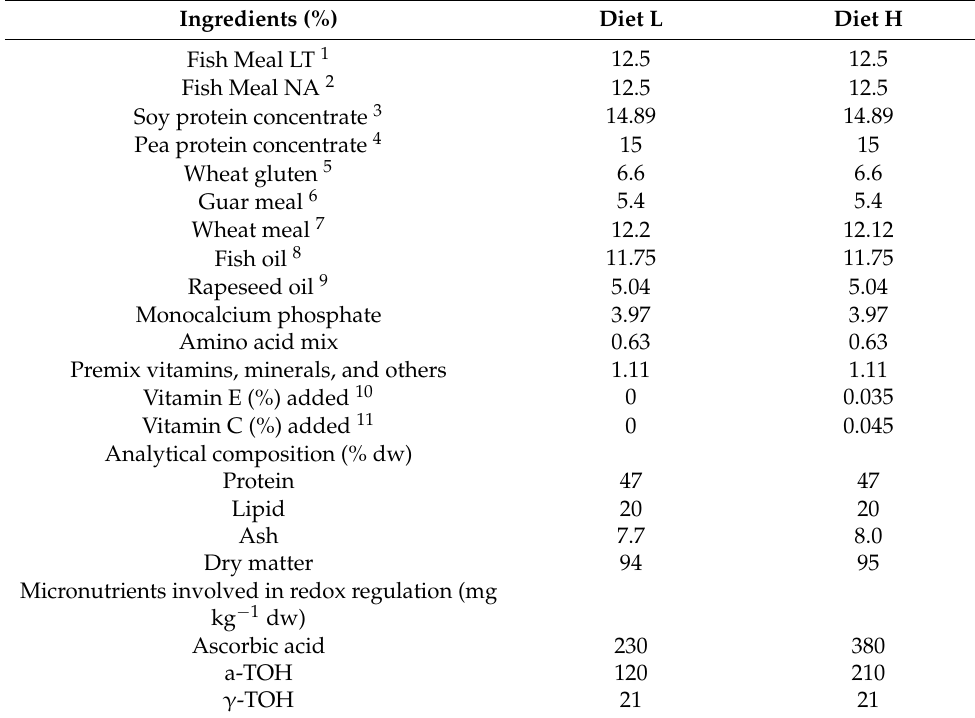
Table 1. Ingredient and chemical composition of the experimental